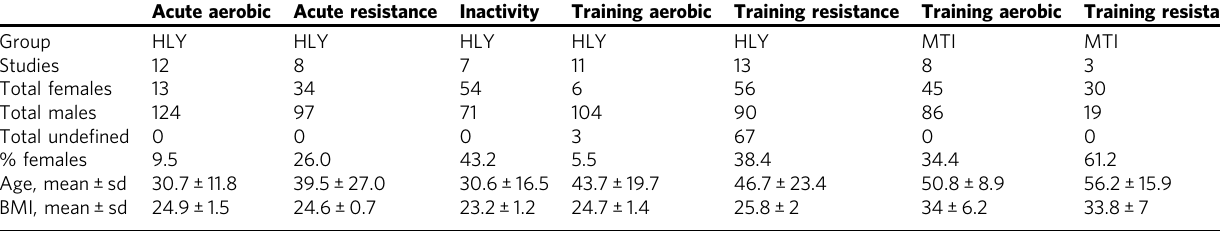
Table 1 Description of the study cohorts included in the